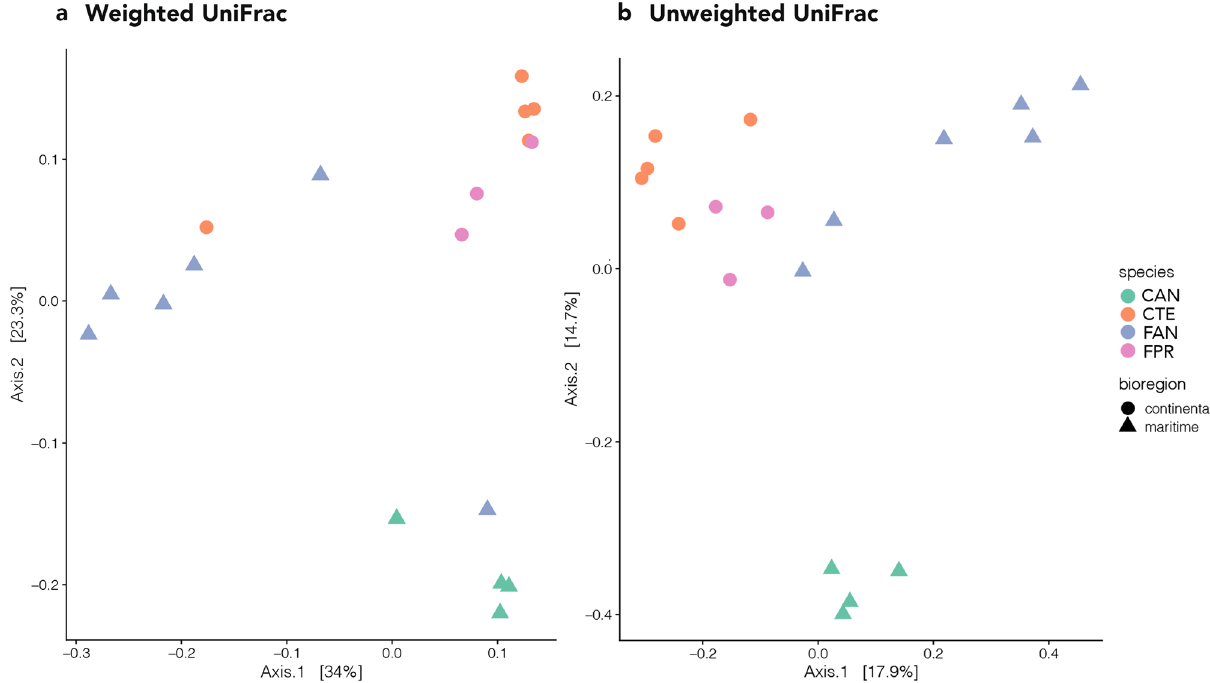
Figure 3. Principal coordinate analysis (PCoA) showing: ( a ) the weighted UniFrac, and ( b ) the unweighted UniFrac distances between the four samples analysed. The figure was generated using the R package ggplot2 v3.2.1 (https ://ggplo t2.tidyv erse.org).